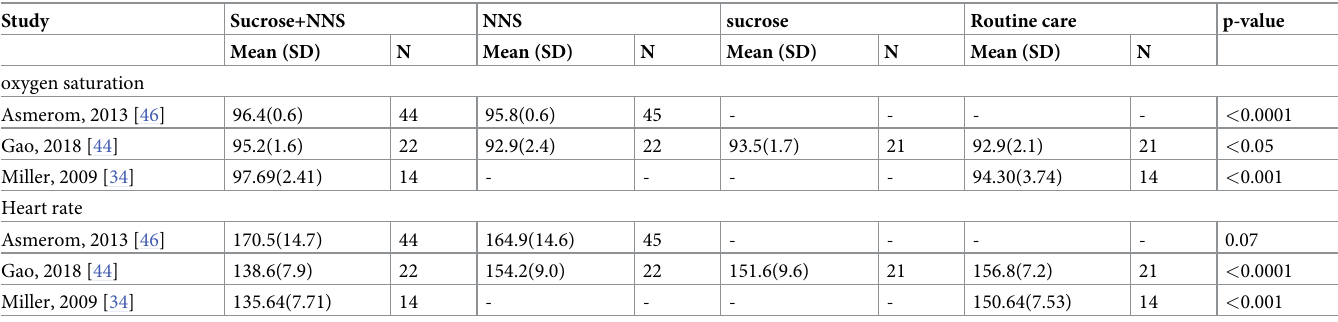
Table 3. Summarized statistics of oxygen desaturation and Heart rate in included studies during painful